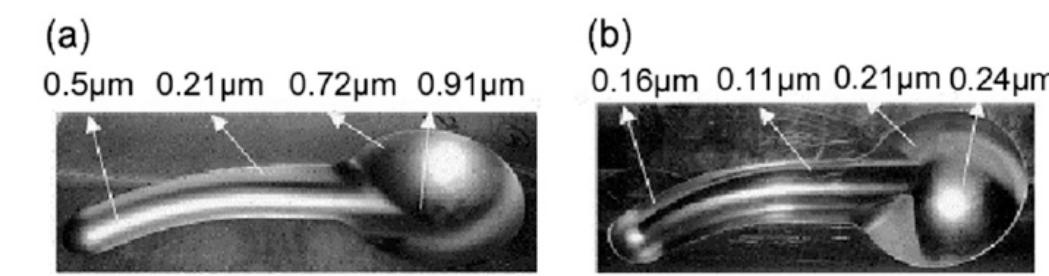
Figure 7. Mold cavity ( a ) without Si powder ( b ) with Si powder [100].